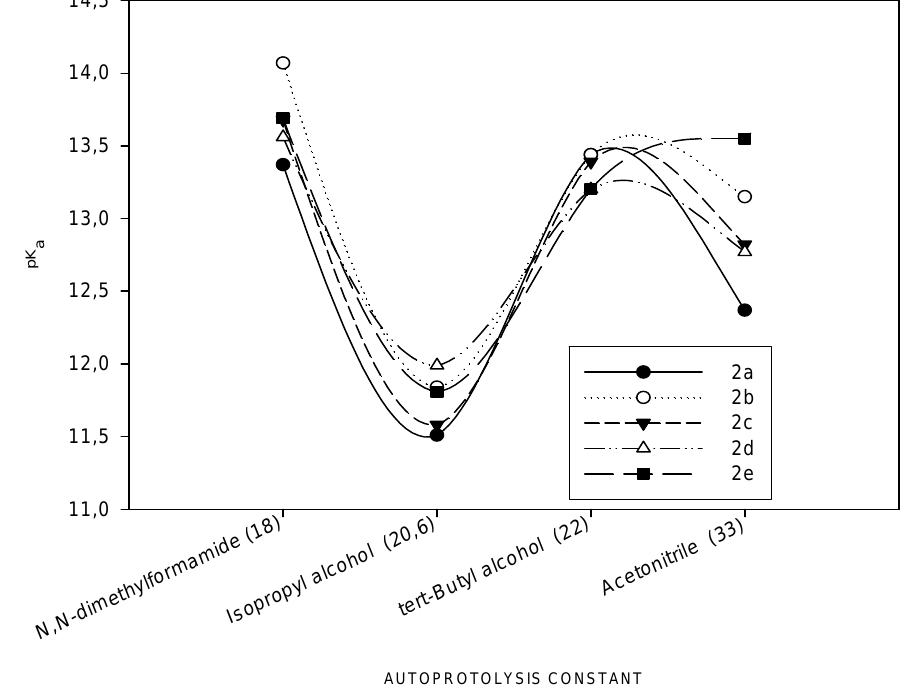
Figure 2. The exchange of the p K